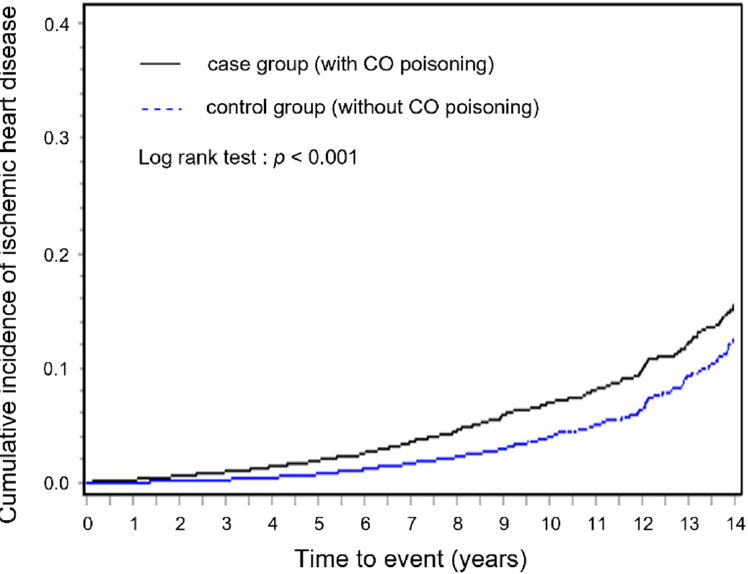
Figure 2. Comparison of cumulative incidence rates among the CO poisoning and control groups. When analyzed by stratification according to socioeconomic factors, the risk of devel- oping IHD among the CO poisoning group compared with the control group was similar in men and women. The risk of developing IHD among the CO poisoning group was much higher for the younger age group (<40 years) (adjusted HR, 4.85; 95% CI, 3.20–7.35), and no significantly increased risk was found for patients aged ≥ 65 years (adjusted HR, 1.15; 95% CI, 0.87–1.51). The risk of developing IHD among the CO poisoning group was the highest for those living in metropolitan areas, except Seoul (adjusted HR, 3.69; 95% CI, 1.79–7.61), while those living in Seoul did not show any significant increase in risk (adjusted HR, 1.25; 95% CI, 0.53–2.95). Based on household income levels, there was a significantly increased risk of developing IHD among the CO poisoning group for all household income deciles, but the effect size of the risk for the high-income group was relatively low. When stratified according to comorbidities, the risk of developing IHD among the CO poisoning group was higher for those with comorbidities (crude HR, 3.00; 95% CI, 1.67–5.38), and this risk was even greater when the model adjusted for covariates (adjusted HR, 10.69; 95%